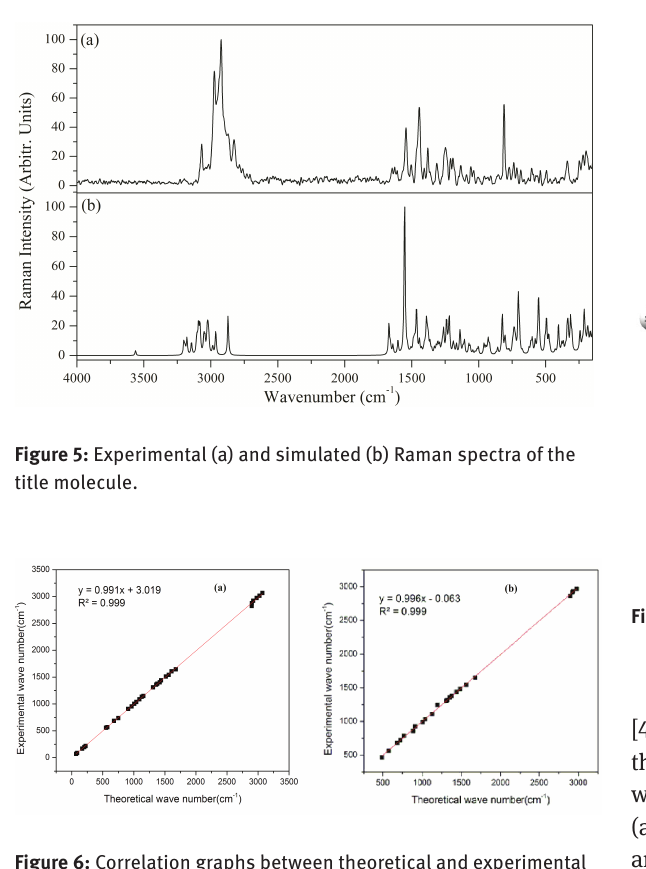
Figure 6: Correlation graphs between theoretical and experimental wavenumbers of (a) FT-IR (b) FT-Raman of the title compound.